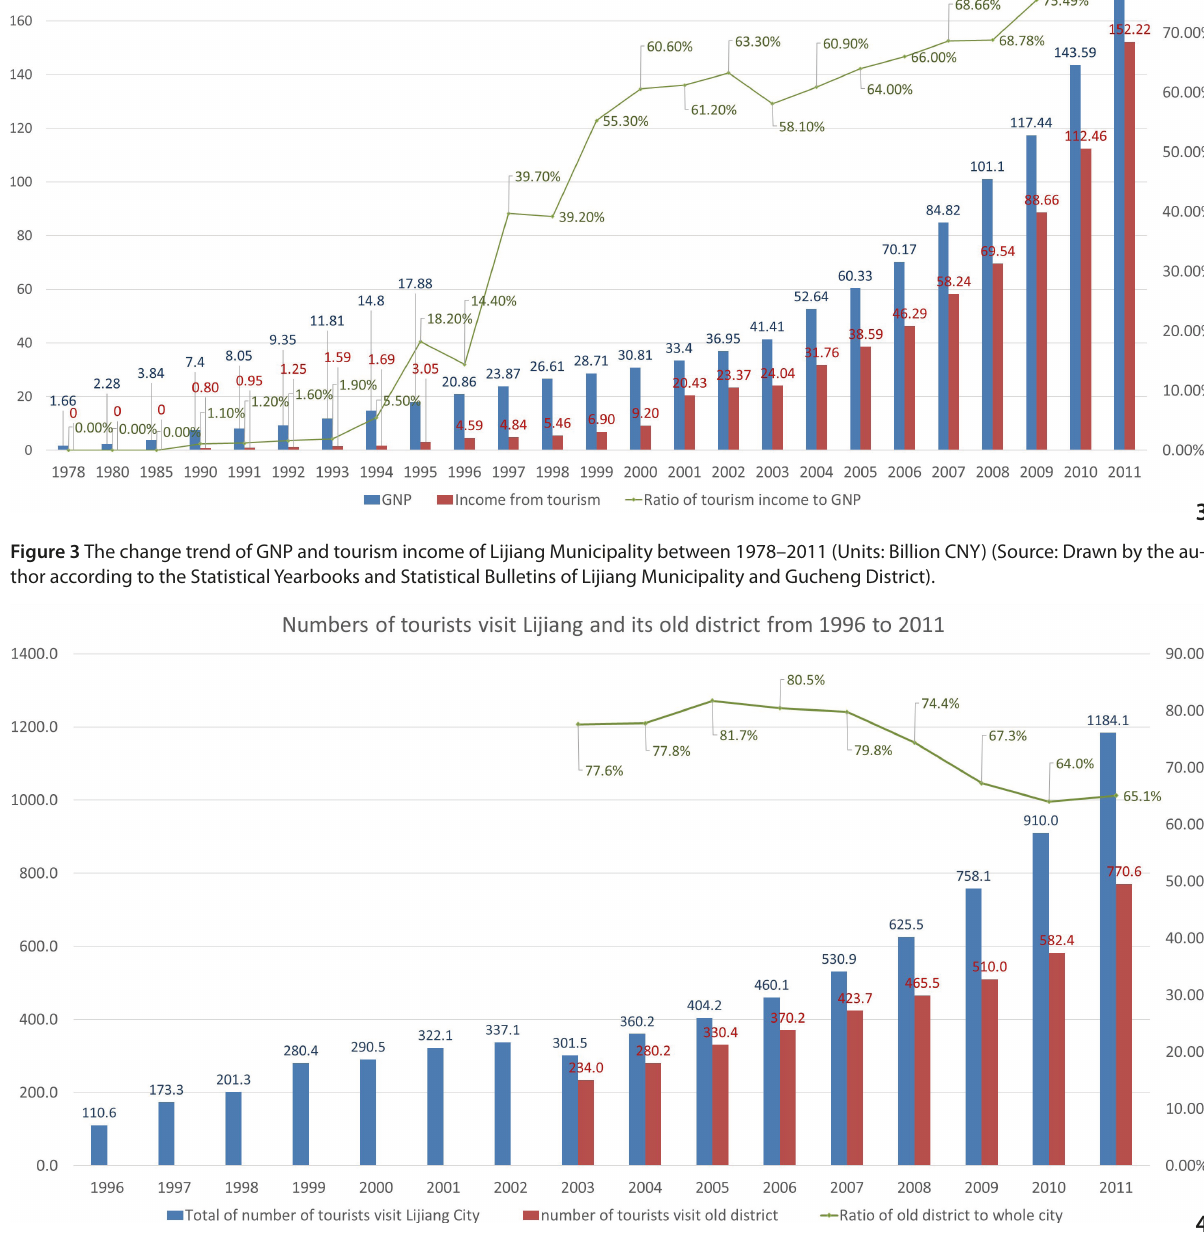
Figure 4 The evolution of tourist number of Lijiang Municipality and Gucheng District 1 between 1996–2011(Units: 10,000 persons) (Source: Drawn by the author according to the Statistical Yearbooks and Statistical Bulletins of Lijiang Municipality and Gucheng District).